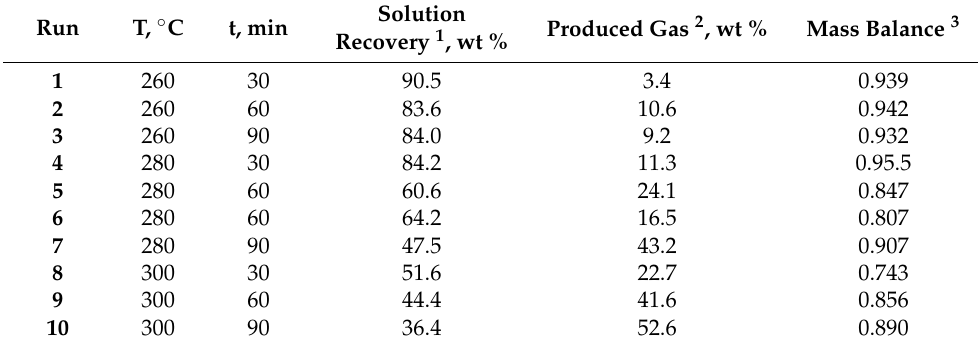
Table 4. Mass balance at the end of the experimental runs based on the total mass recovered.